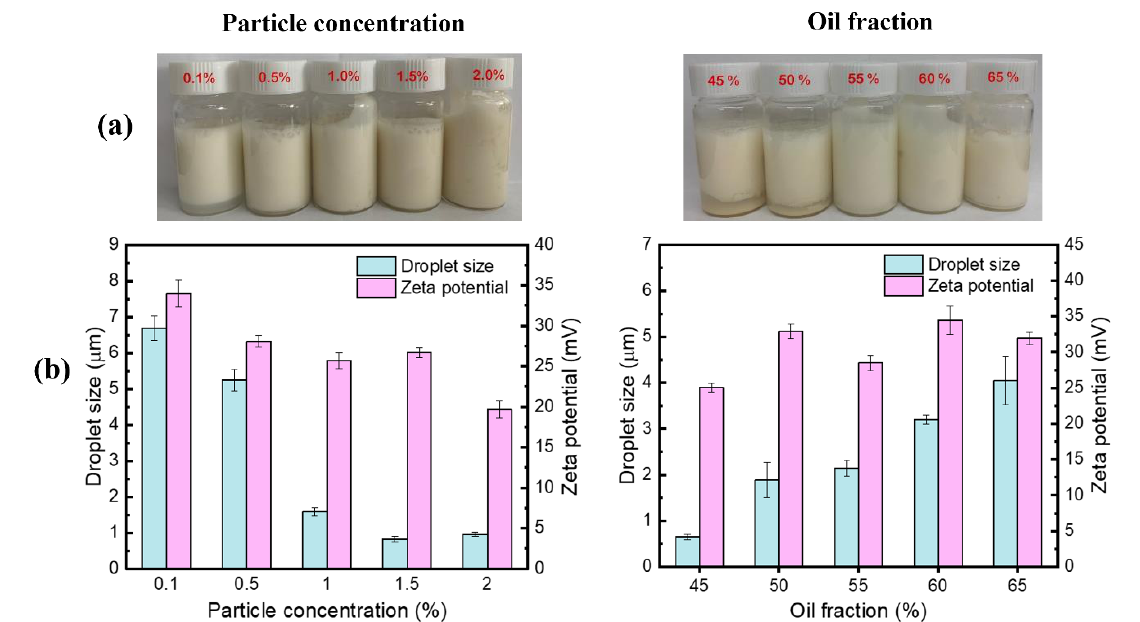
Figure 6. ( a ) Appearance, ( b ) droplet size and zeta potential of droplets of Pickering emulsions under different particle concentrations (fixed oil fractions: 50%) and oil fractions (fixed particle concentration: 1%).